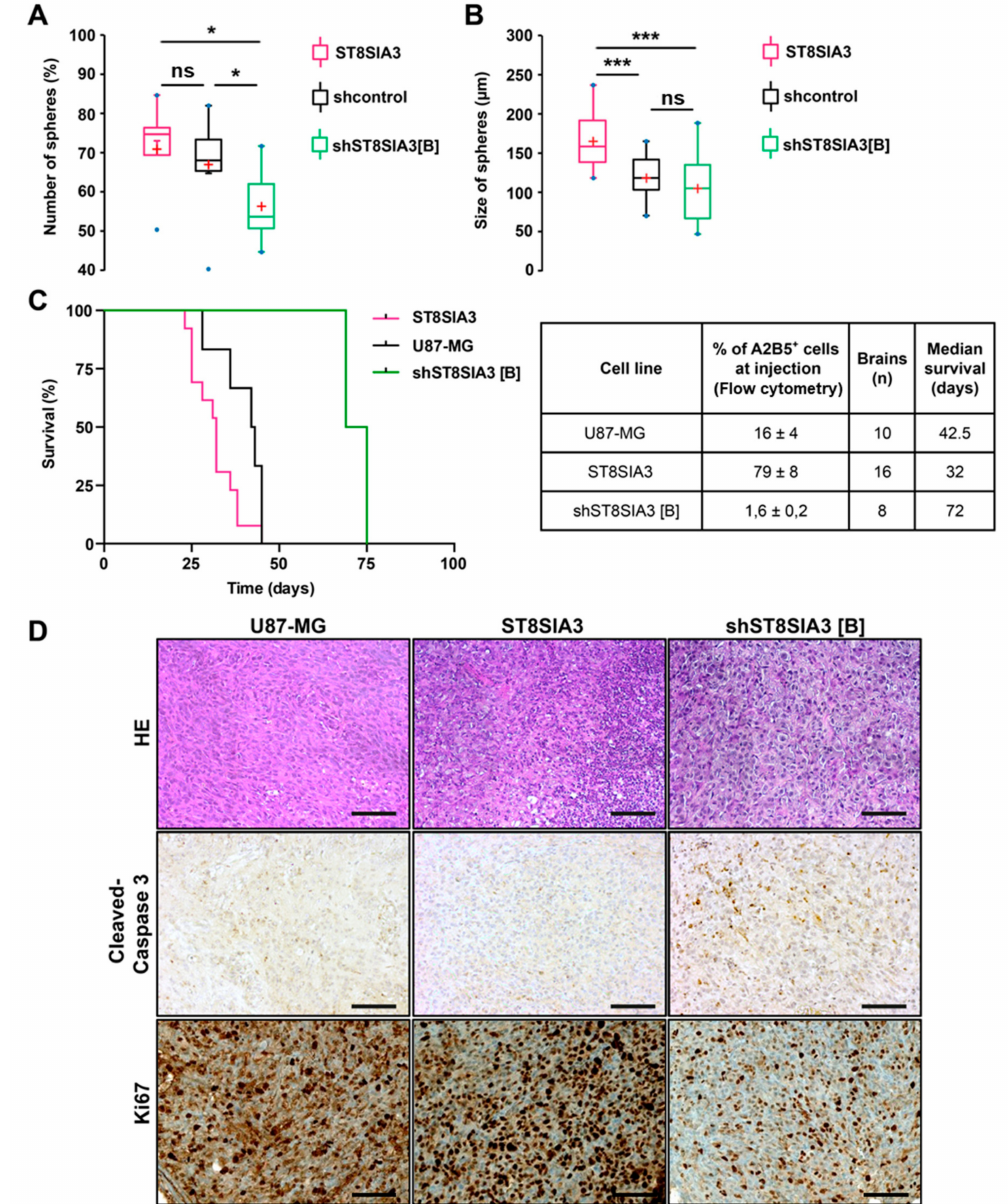
Figure 3. ST8SIA3 enhances in vitro clonogenicity and in vivo tumorigenicity. ( A ) Self-renewal capacity was evaluated by limiting dilution assay in 96-well plates. Box plots show the percentage of spheres formed after 8 days of culture for U87-shcontrol, U87-ST8SIA3, and U87-shST8SIA3 [B] cell lines. ( B ) Mean diameter of spheres recorded for U87-shcontrol, U87-ST8SIA3, and U87-shST8SIA3 [B] after 8 days of culture. Non-parametric Wilcoxon–Mann–Whitney test shows * p < 0.05 and *** p < 0.001. ns: non-significant. The lower and upper edges of each box represent the first and third quartiles, respectively, while the horizontal line within the box indicates the median. The vertical length of the box represents the interquartile range (IQR). The most extreme sample values (within a distance of 1.5 IQR from the median) are the endpoints of the extending lines. ( C ) Kaplan–Meier survival plot of mice intracerebrally grafted with U87-MG, U87-ST8SIA3, or U87-shST8SIA3 [B] cells. Time is expressed in days since time of cell graft. Groups were compared using the Log-rank test. The table recaps the percentage of A2B5 + cells before injection, number of brains analyzed, and median survival of mice. ( D ) Representative hematoxylin–eosin (HE), cleaved-caspase 3, and Ki67 staining of tumors obtained after U87-MG, U87-ST8SIA3, or U87-shST8SIA3 [B] orthotopic injections. Scale bar: 100 µ